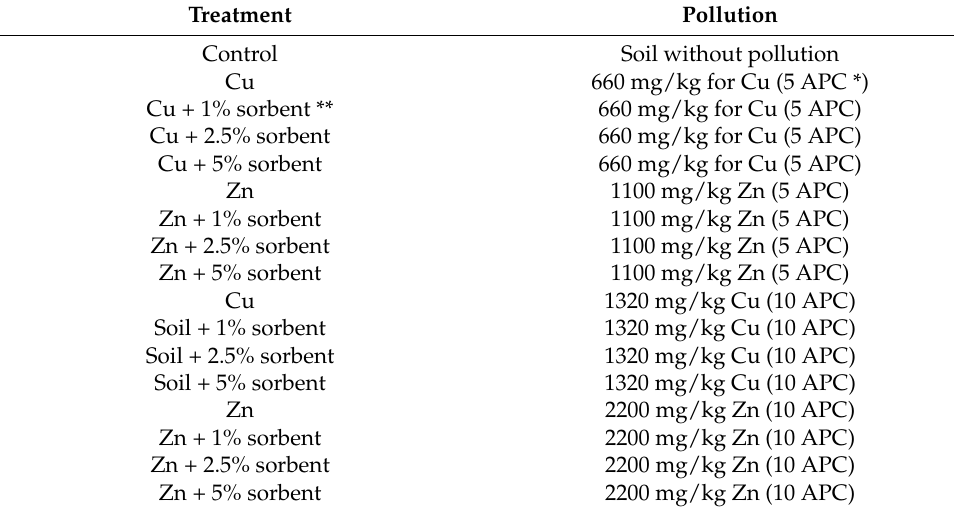
Table 1. The scheme of the experimental treatments.